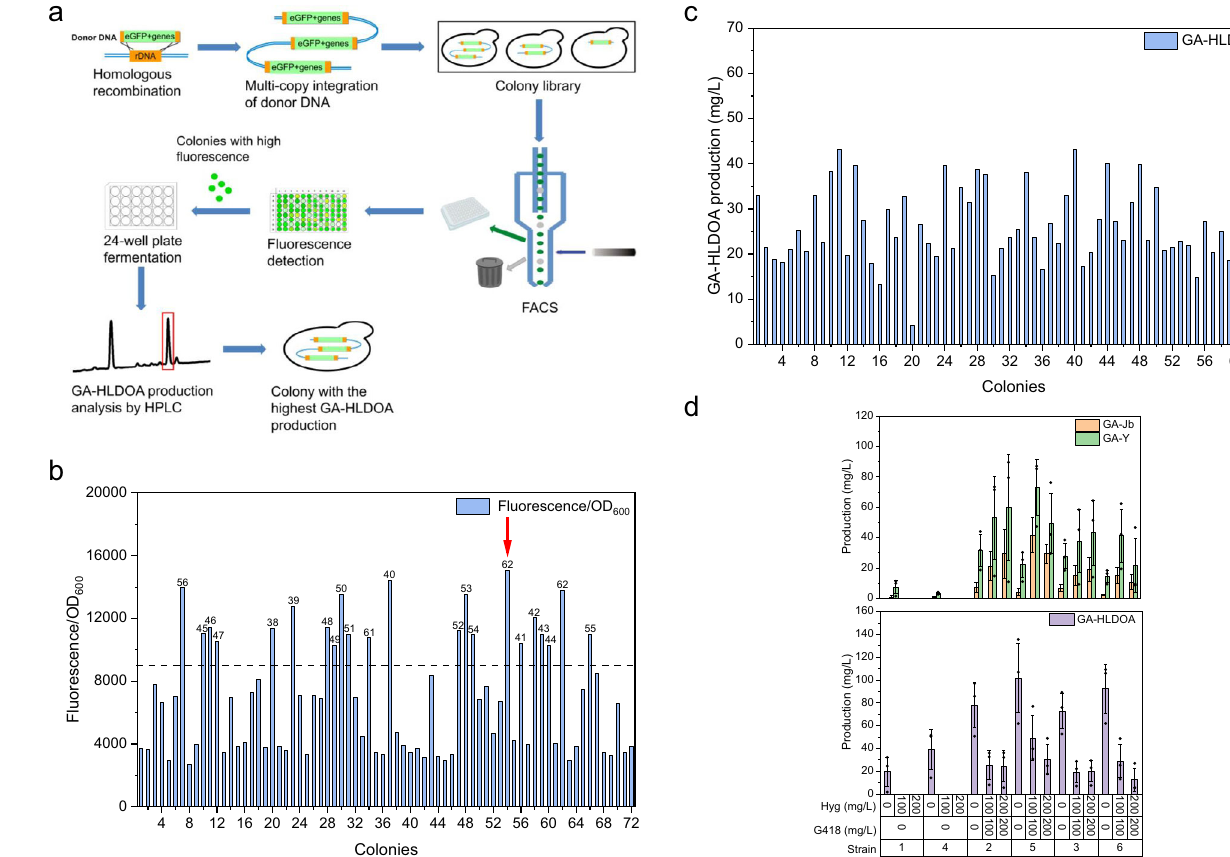
forfermentationtests.Thenumberabovethedottedlineindicatesthenameofthe selected clone. c Production of GA-HLDOA after 120h of fermentation using the selected clones. d Production of 4 , 3 , and GA-HLDOA after 120h of fermentation using the engineered strains. Strain 1, SC62-CYP512W2-r; strain 2, SC62-CK-r- CYP512W2-r; strain 3, SC62-CYP5037B21-r-CYP512W2-r; strain 4, SC62-CYP512W2- iGLCPR-r;strain5,SC62-CK-r-CYP512W2-iGLCPR-r;andstrain6,SC62-CYP5037B21- r-CYP512W2-iGLCPR-r. All data represent the mean of three biologically indepen- dent samples (solid circles in d ), and the error bars show the standard deviation. Source data are provided as a Source Data fi